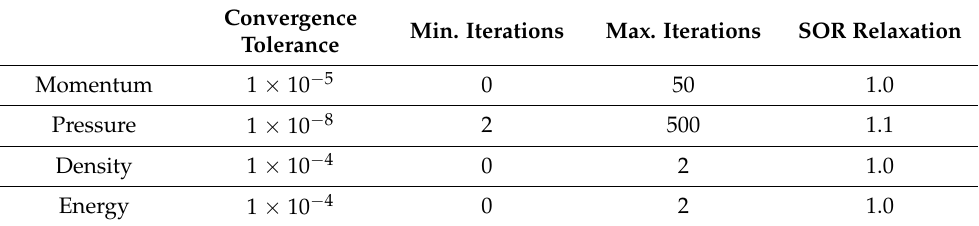
Table 1. Overview of SOR settings for the governing equations regarding convergence tolerance, minimum and maximum iterations, and SOR Relaxation value.